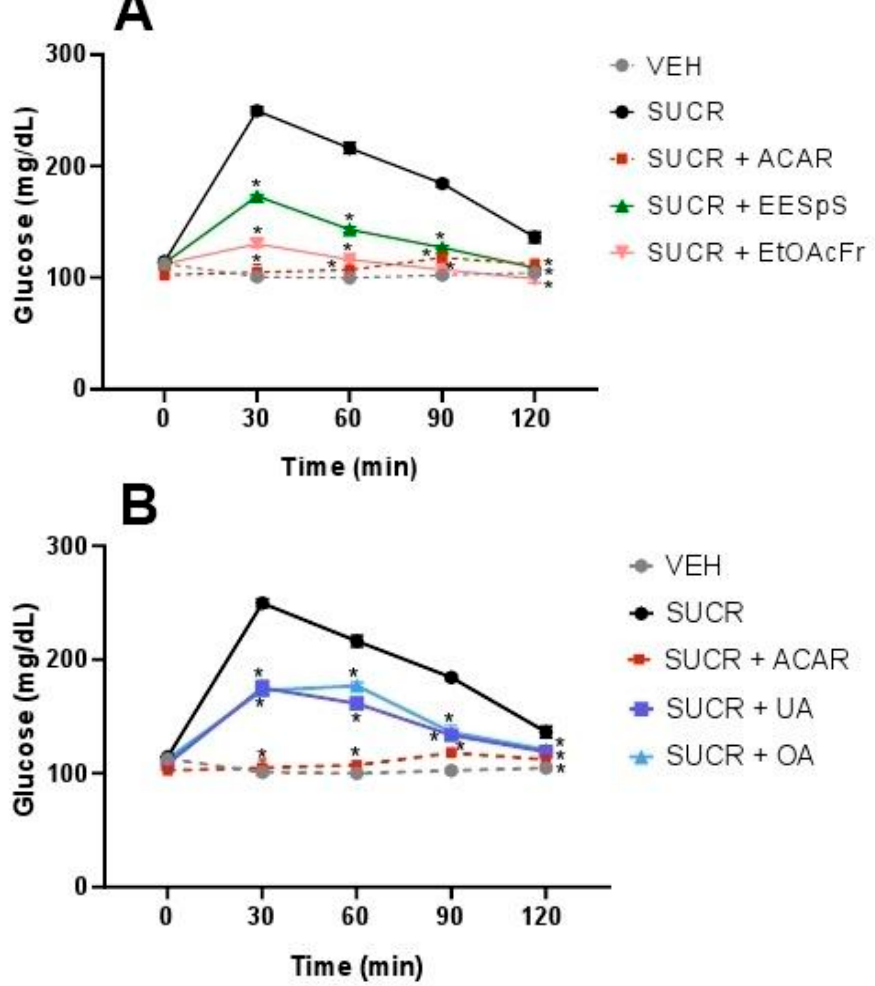
Figure 2. Effect of products obtained from the stems from S. polystachya in oral sucrose tolerance test (OSuTT). ( A ) OSuTT of groups treated with sucrose, acarbose, EESpS and EtOAcFr, as well as vehicle. ( B ) OSuTT of groups treated with sucrose, acarbose, UA and OA, as well as vehicle.